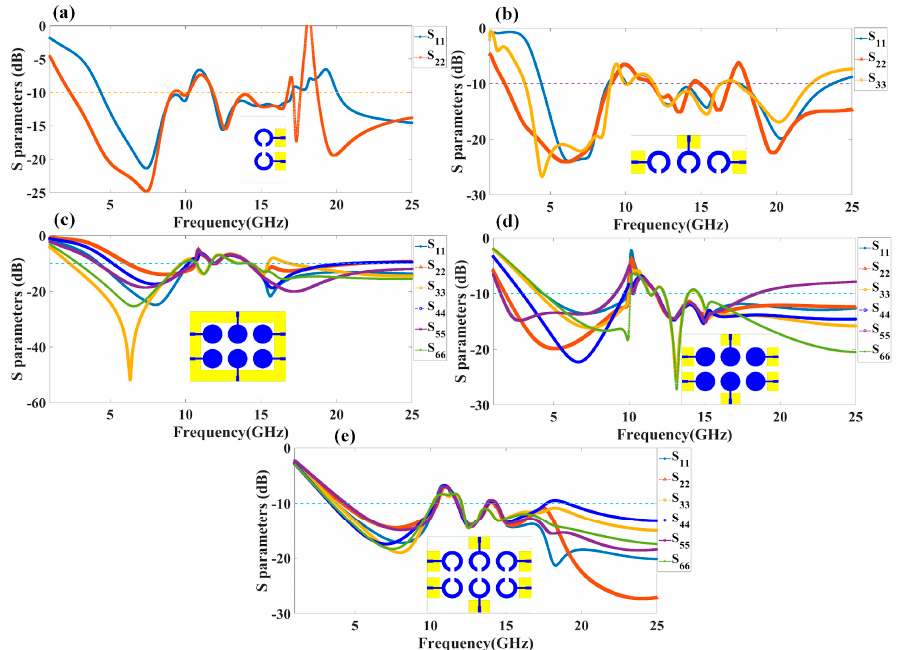
Figure 4. Measured values of reflectance coefficients for the different proposed MIMO antenna designs: ( a ) Design 1, ( b ) Design 2, ( c ) Design 3, ( d ) Design 4, and ( e ) Design 5. The results are presented in terms of the return loss parameters, such as S 11 , S 22 , S 33 , S 44 , S 55 , and S 66 . A dotted line is put for the reference to identify the reflectance < − 10 dB. Table 4. Measurement-based derived results and comparative analysis for the different antenna